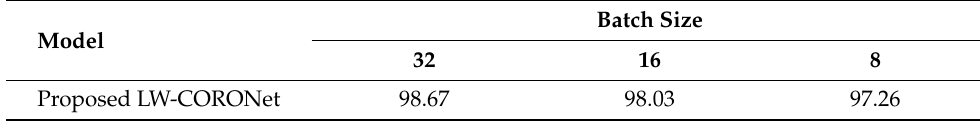
Table 9. Accuracy of LW-CORONet with different batch